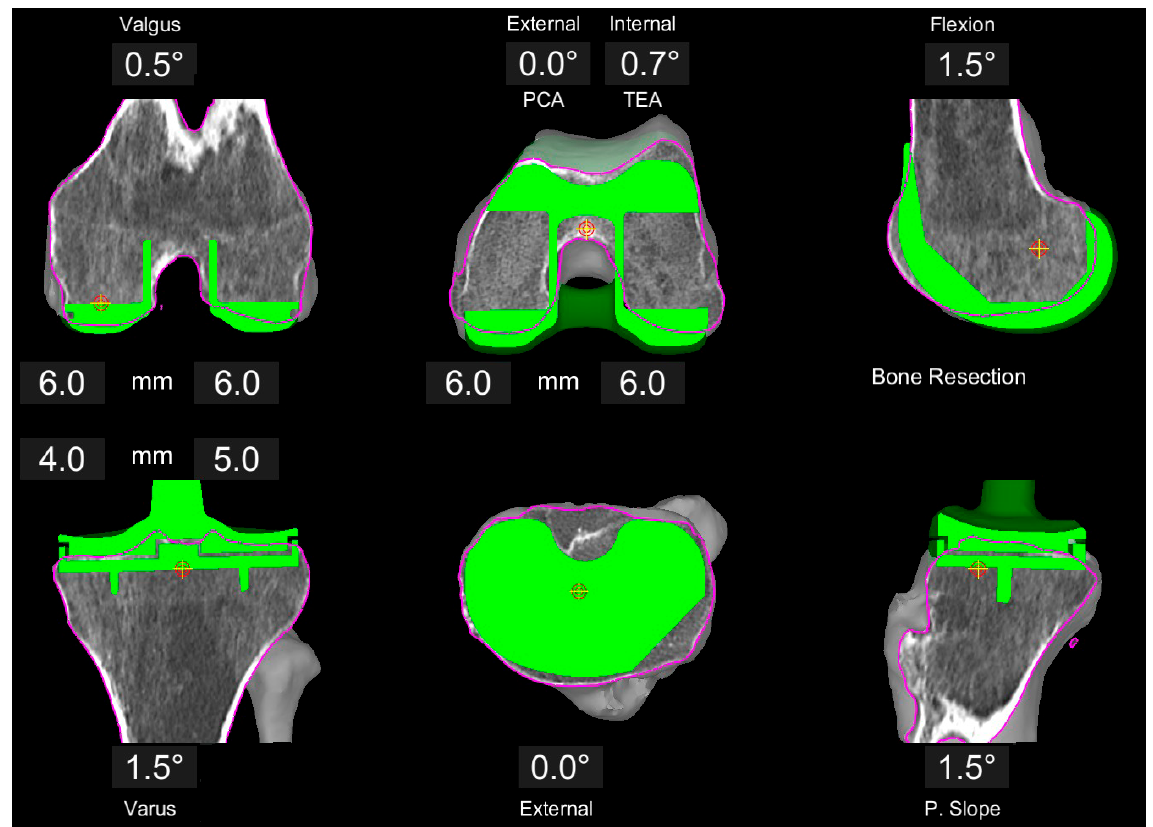
Figure 1. Example of image-based planning of the component position based on the principles of KA. Femoral resections are set to 6 mm each, resulting in 0.5° valgus position and 0.7° internal rotation with respect to the TEA. Tibia plan is preliminary at 1.5° varus, 1.5° slope and a resection level of 4 and 5 mm, respectively.